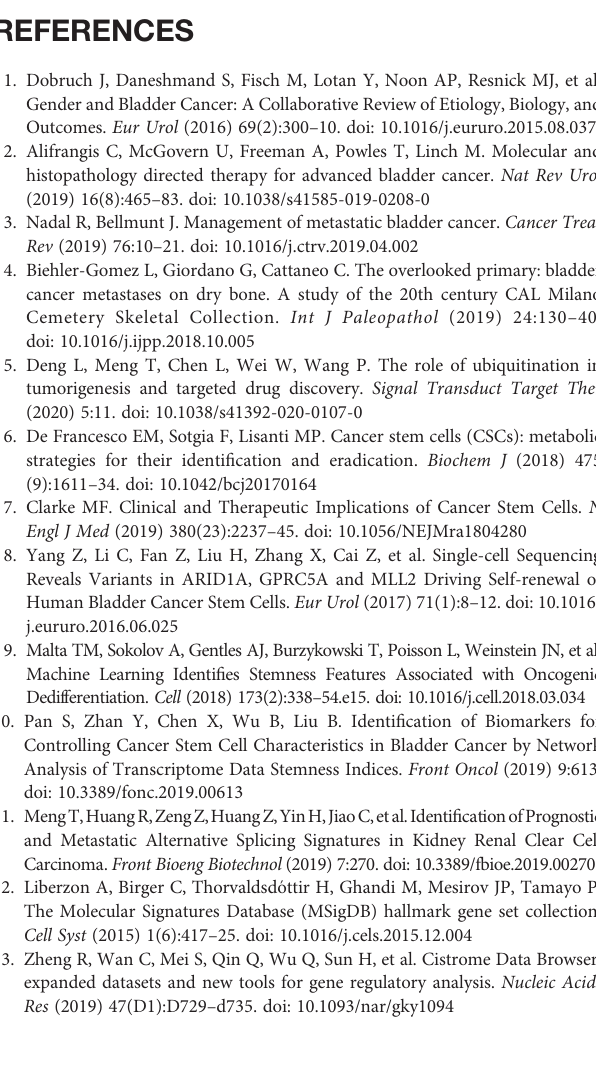
nomogram. The time-related ROC with 95% con fi dence interval (C) , decision curve (D) and residual plot (E) were also conducted to illustrate the patient bene fi t and the discrimination of the nomogram. (***P < 0.001; **P < 0.01; **P < 0.05). Supplementary Figure 5 | Construction of the prognostic nomogram with 164 objectives with all available variables and excluding all missing values (A) The constructed prognostic nomogram based on the multivariate Cox model. (B) The calibration curveillustrated acceptable calibration of the prognostic nomogram. The time-related ROC with 95% con fi dence interval (C) , decision curve (D) and residual plot (E) werealsoconducted toillustratethepatientbene fi tandthe discriminationof the nomogram. Note: (***P < 0.001; **P < 0.01; **P < 0.05). Supplementary Figure 6 | Construction of the prognostic nomogram with 164 objectives with all available variables except for age and gender and excluding all missing values (A) The constructed prognostic nomogram based on the multivariate Cox model. (B) The calibration curve illustrated acceptable calibration of the prognostic nomogram. The time-related ROC with 95% con fi dence interval (C) , decision curve (D) and residual plot (E) were also conducted to illustrate the patient bene fi tandthediscriminationofthenomogram.(***P<0.001;**P<0.01;**P<0.05). Supplementary Figure 7 | The protein levels of key TFs and PRSGs in BLCA and normal urinary bladder in the Human Protein Atlas. The representative IHC images ofEPO (A) , ARID3A (B) ,SSX3 (C) andCGA (D) inBLCAandnormalurinarybladder